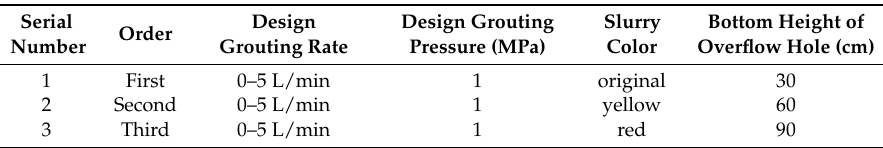
Table 3. Selection of grouting parameters.